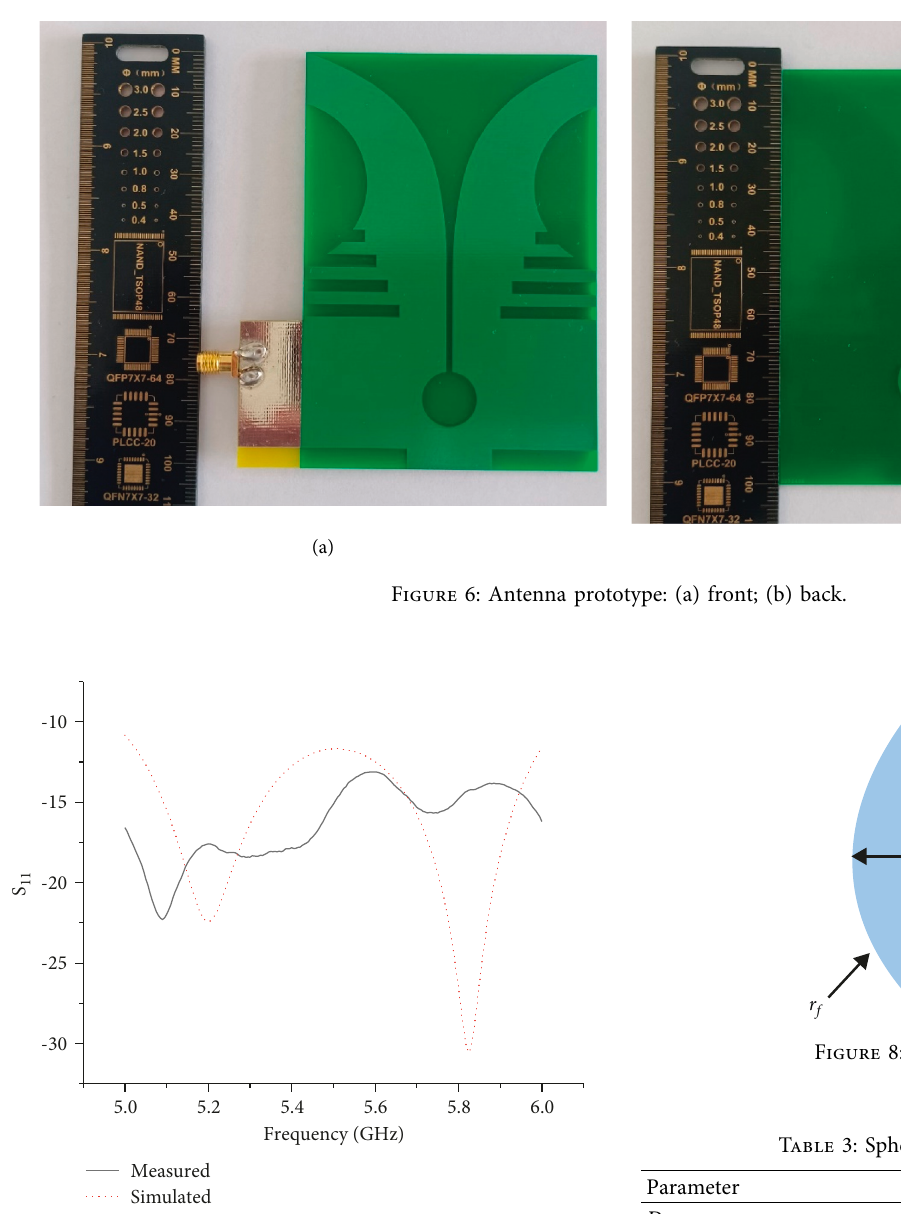
Figure 7: Frequency behavior of antenna reflection coefficient.